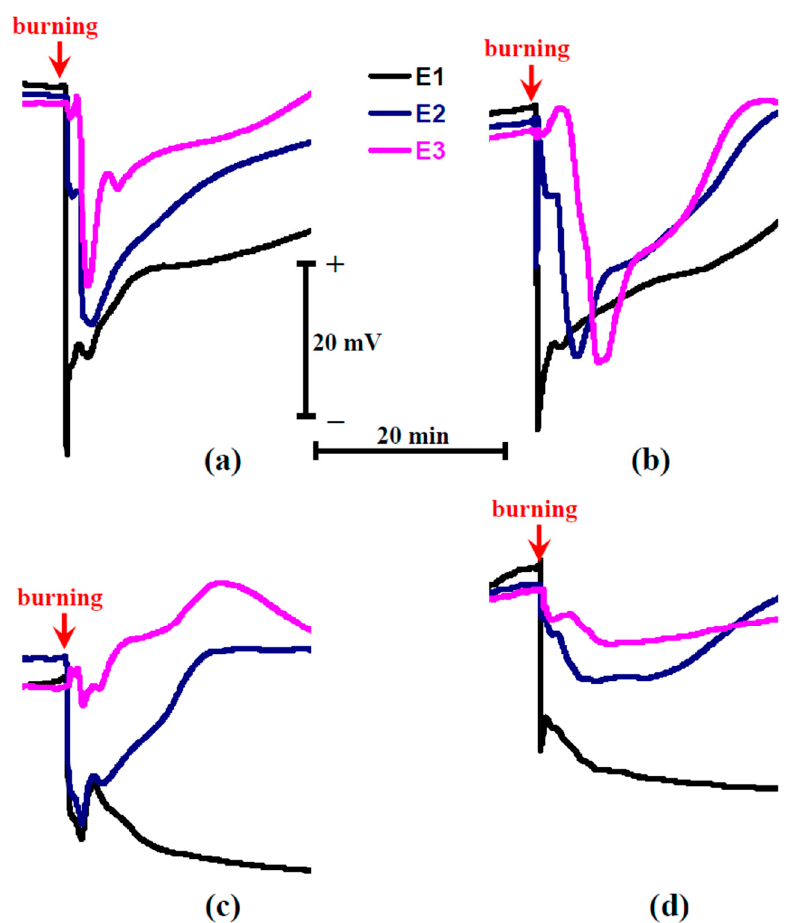
Figure 2. Records of burning-induced electrical signals in control pea seedlings ( a ), seedlings after 2 days of water shortage ( b ), and seedlings after 4 days of this shortage ( c , d ). Extracellular measurements in the stem near to the first mature leaf (E1), the stem near to the second mature leaf (E2), and leaflet of the second mature leaf (E3) are shown. Arrow marks the time of the burning of the first mature leaf. Figure 2c shows the hyperpolarization electrical signal in the second leaf which was observed in two peas from six plants after 4 days of water shortage; Figure 2d shows a weak depolarization electrical signal in the second leaf which was observed in four peas from six plants after 4 days of water shortage. Only depolarization signals were observed in control plants and plants after 2 days of water